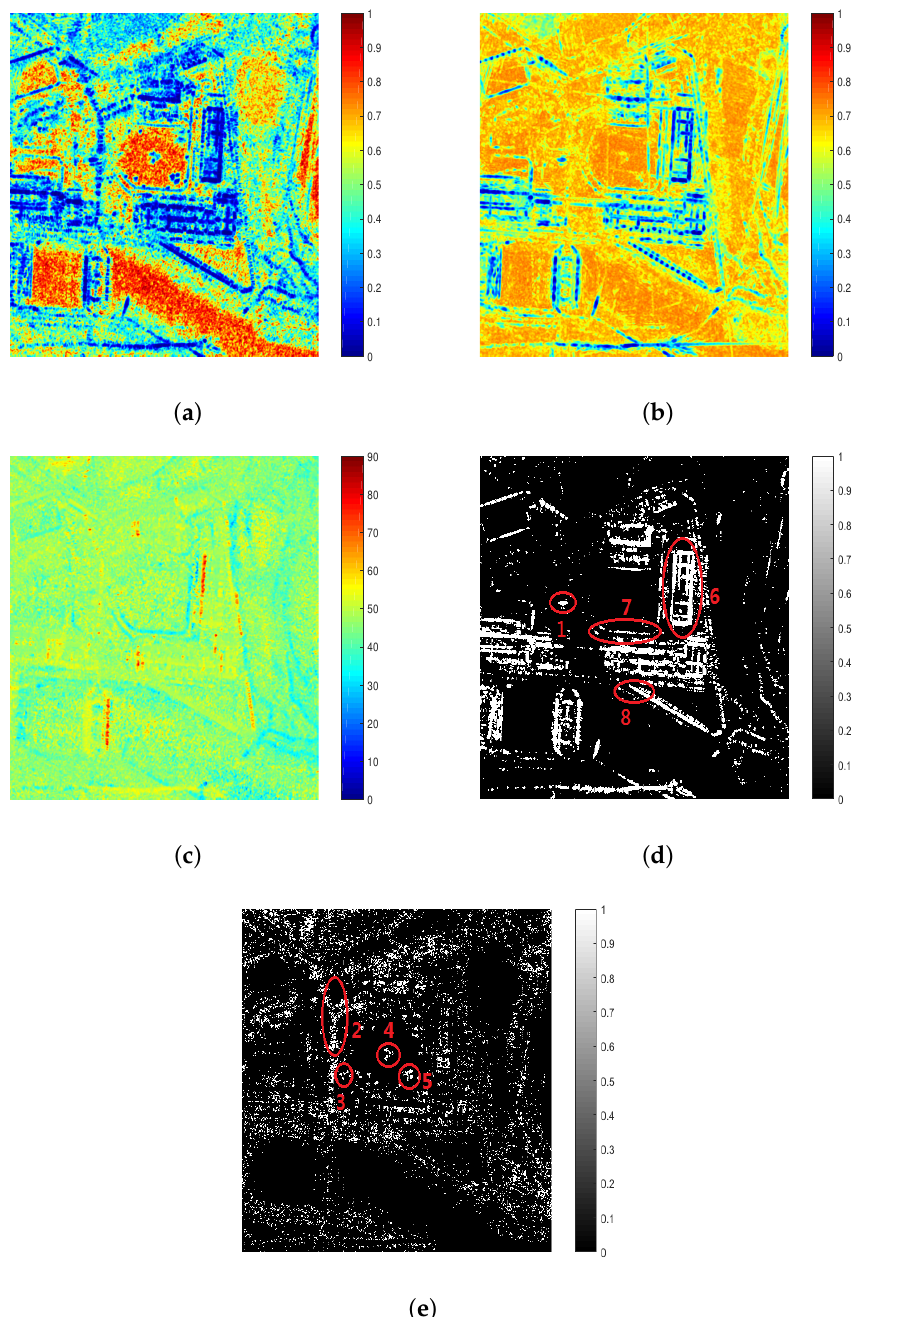
Figure 8. Images from Figure 4a rendered as: ( a ) polarimetric entropy; ( b ) MAPE; ( c ) α ; ( d ) anisotropic; and ( e ) isotropic